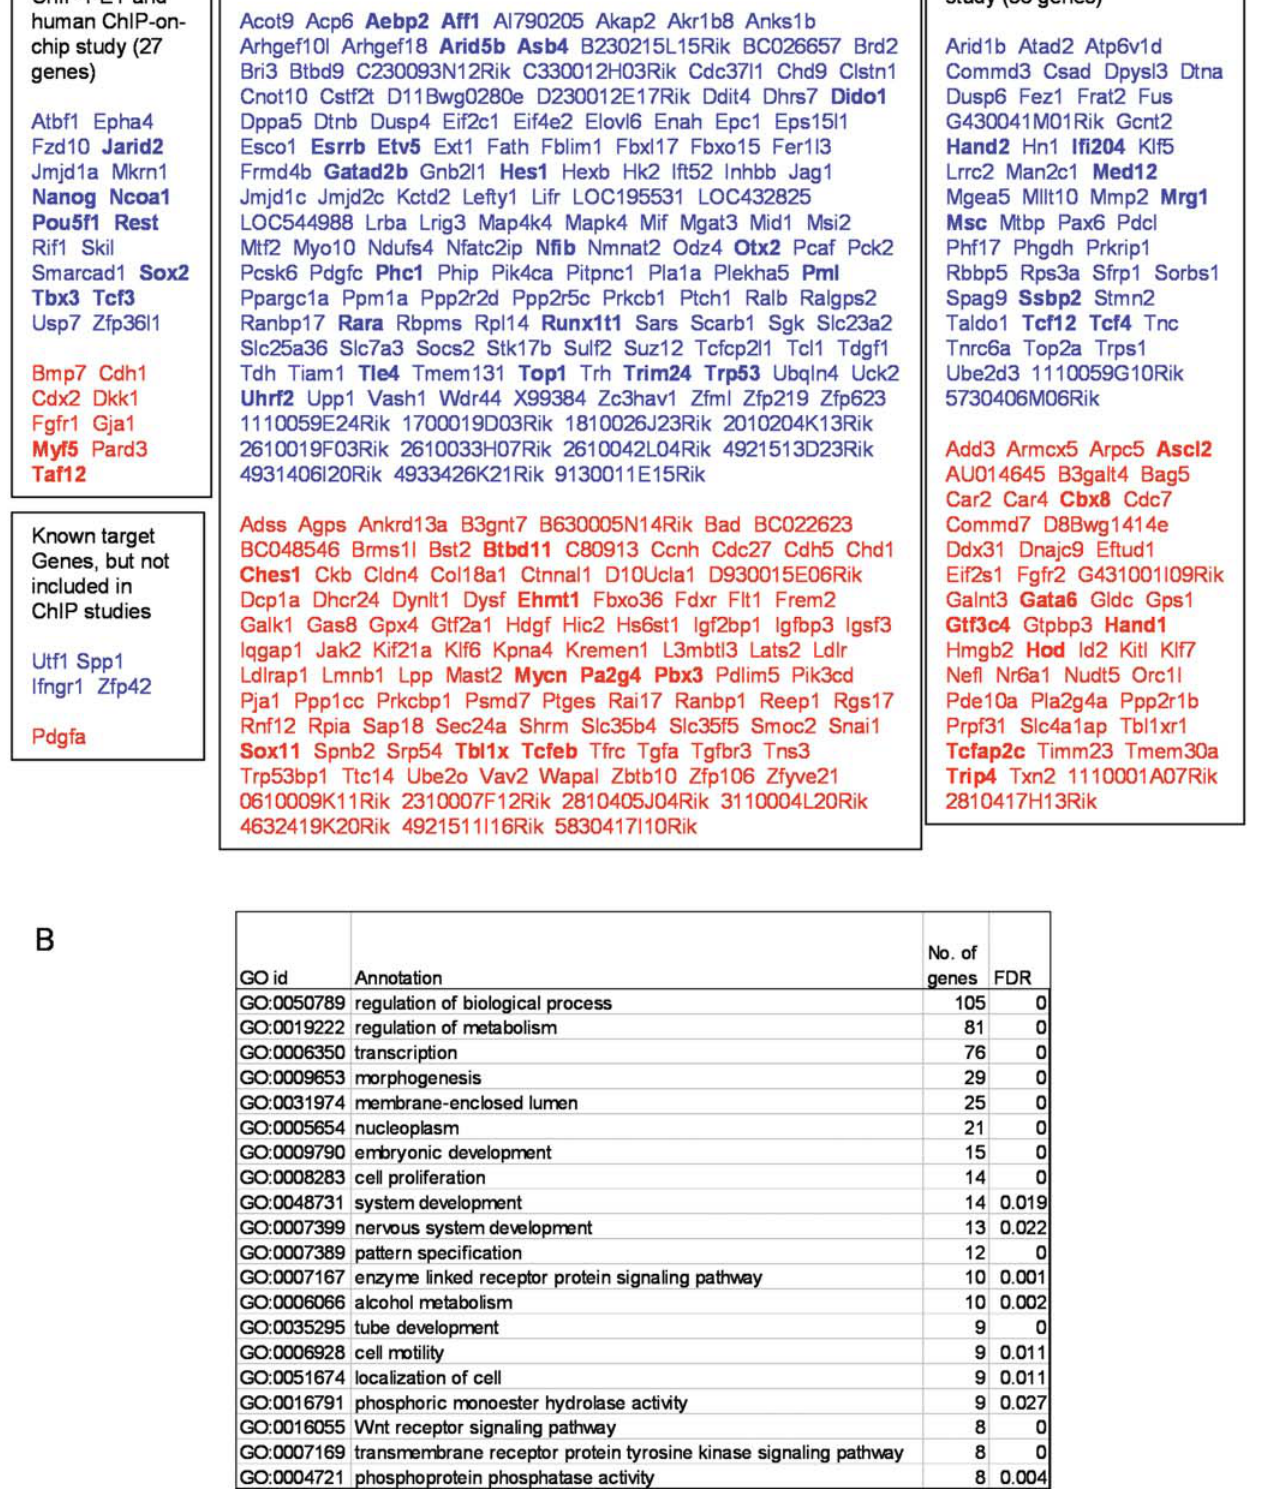
Figure 4. (A) Primary targets of Oct3/4. Genes are separated into four groups: Genes detected by the current expression profiling, mouse ChIP-PET assay, and human ChIP-on-chip assay; previously known target genes that were also detected by the current expression profiling; Genes detected by the current expression profiling and mouse ChIP-PET assay; Genes detected by the current expression profiling and human ChIP-on-chip assay. Genes classified as transcription factors by GO annotation were shown in bold. Genes that were down-regulated by the repression of Oct3/4 in ZHBTc4 cells were shown in blue. Genes that were up-regulated by the repression of Oct3/4 in ZHBTc4 cells were shown in red. (B) Representative GO categories that are enriched in the primary targets of Oct3/4 in a statistically significant manner (FDR . 0.05). doi:10.1371/journal.pone.0000026.g004 PLoS ONE |